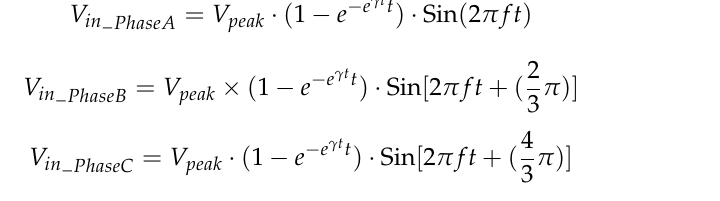
Figure 3. The B - H curve of the iron core diagram.